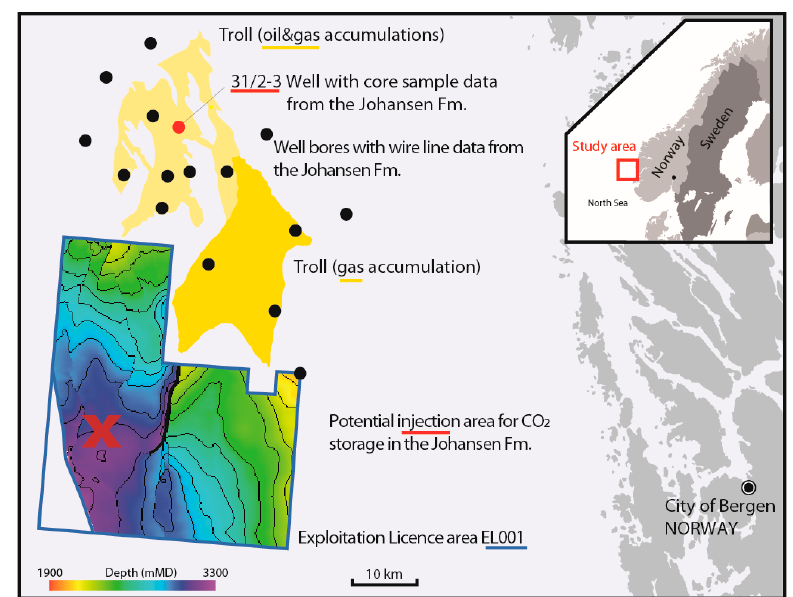
Figure 1. The Johansen Formation is a prospective CO 2 storage reservoir offshore of Norway, located at burial depths of ca. 2100–3200 m. The operating hydrocarbon field “Troll” (yellow) is located north of the licensed CO 2 injection area “EL001”. The cored well 31/2-3 is marked in red, and additional wells with wire line data from the Johansen Formation are marked as black dots. There are no well data available from EL001 as of yet, while an appraisal well is planned [26]. Source data are available at factmaps.npd.no, with suggested injection area and depth maps as shown in [29].